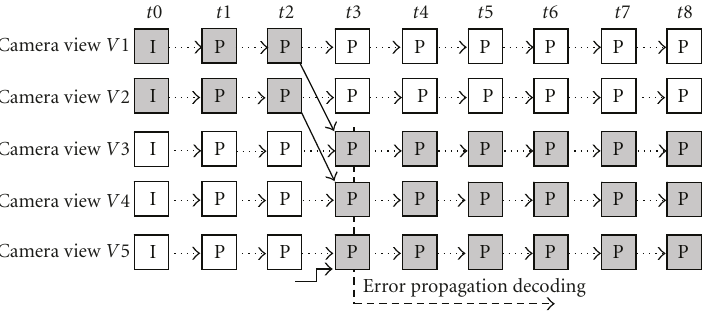
Figure 4: “Simul-switching” in dynamic light field streaming.